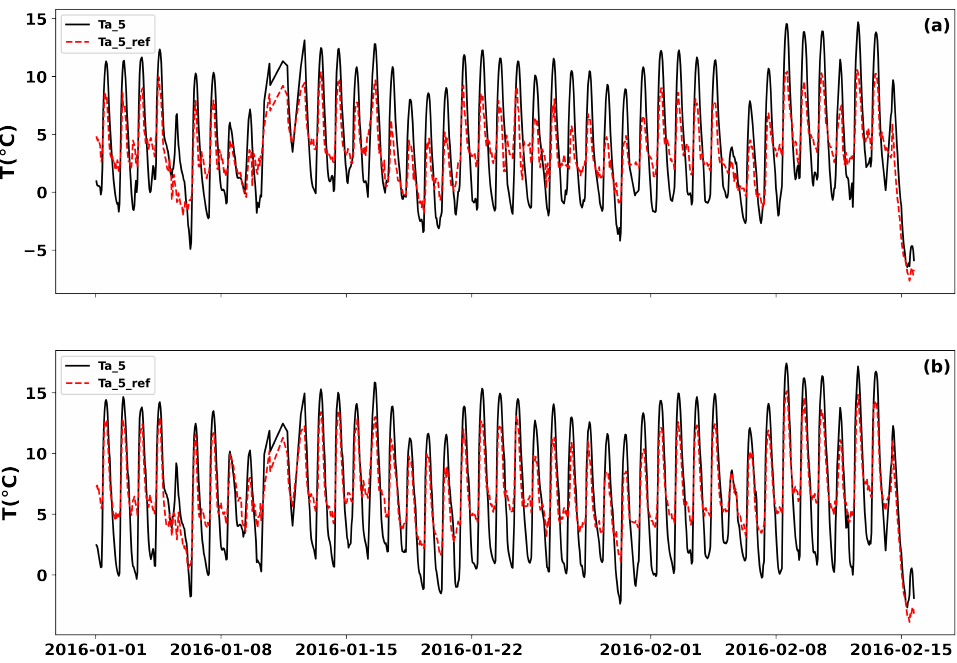
Figure 6. Hourly Comparison of Ta_5 and reference Ta_5_ref over time (as dashed red line and black line, respectively). Example of the ERA5-Land grid situated at ( a ) 7.9° W and 31.1° N, and ( b ) 7.9° W and 31.2°